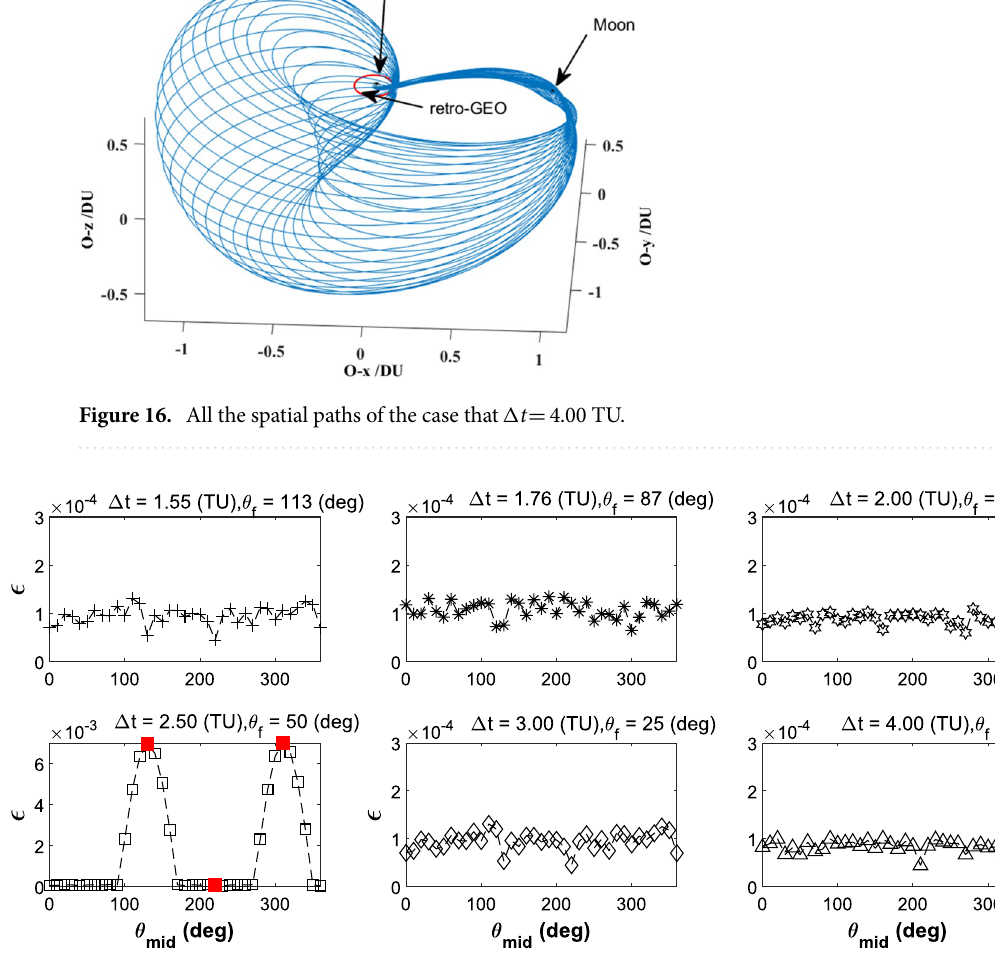
Figure 17. The value of ε with different Sun’ azimuths.